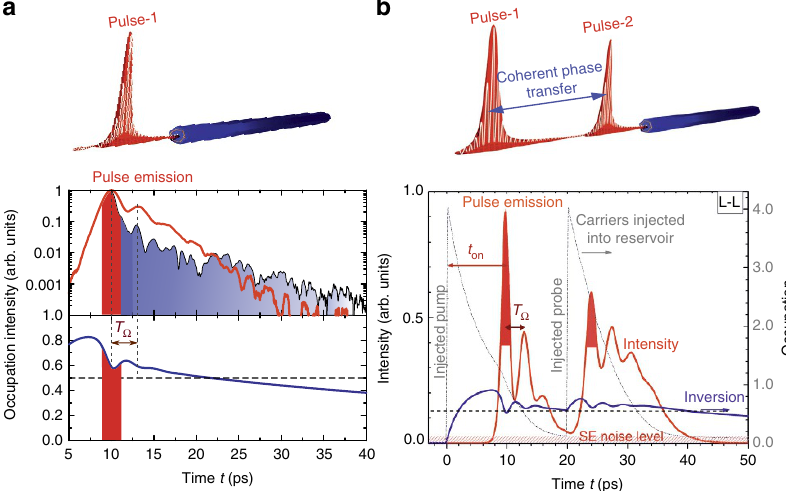
Figure 4 | Coherent-phase information transfer between two subsequent NW laser pulses. ( a ) Time dependence of the emitted intensity obtained by Fourier transforming the optical spectra of the NW laser after only the pump pulse with P / P th ¼ 4 was injected (red line: simulations, black line: experimental data) and computed occupation of the lasing state (blue line) as a function of time. The schematic illustration depicts a NW laser that emits a single pulse. ( b ) Directly simulated time-dependent emission (red line) of the NW after a pump and probe pulse in the lasing regime (L-L) separated by D t ¼ 20ps were injected (thin dotted line). Blue line shows the inversion of the laser level and the hatched region depicts the spontaneous emission noise level. The red regions in a , b mark the short pulse emission during the first Rabi oscillation ( T O marks the Rabi oscillation period and t on the time needed to reach inversion after the pump pulse arrived). The schematic illustration depicts a NW laser that emits a coherent pulse